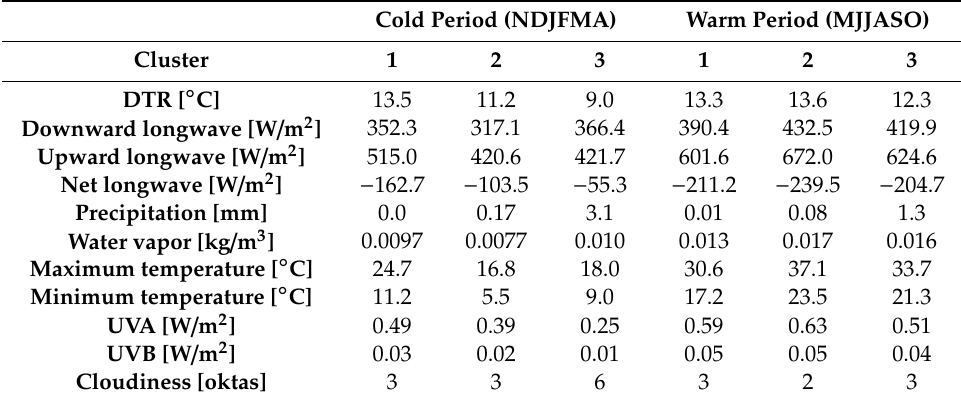
Table 3. Mean values of investigated parameters for night-time data of the suburban station for the three clusters of each period.